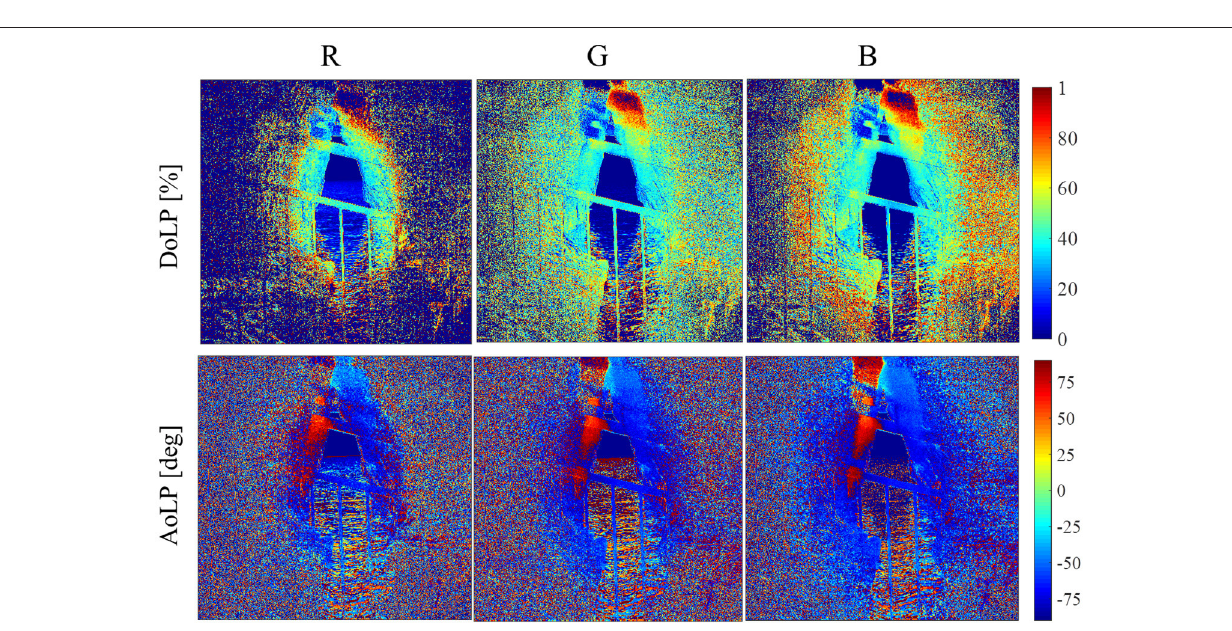
each image are not uniform; different patches of the cave walls exhibit different AoLPs. There is a distinct difference in AoLP between the two sides of the cave opening, not only on the roof of the cave but on the entirety of the cave walls. On the right-hand- side of the images, the AoLP is in the area of − 70 ◦ , while on the left-hand-side of the images, there is a long strip of + 70 ◦ AoLP. This strong variation in AoLP between different patches of